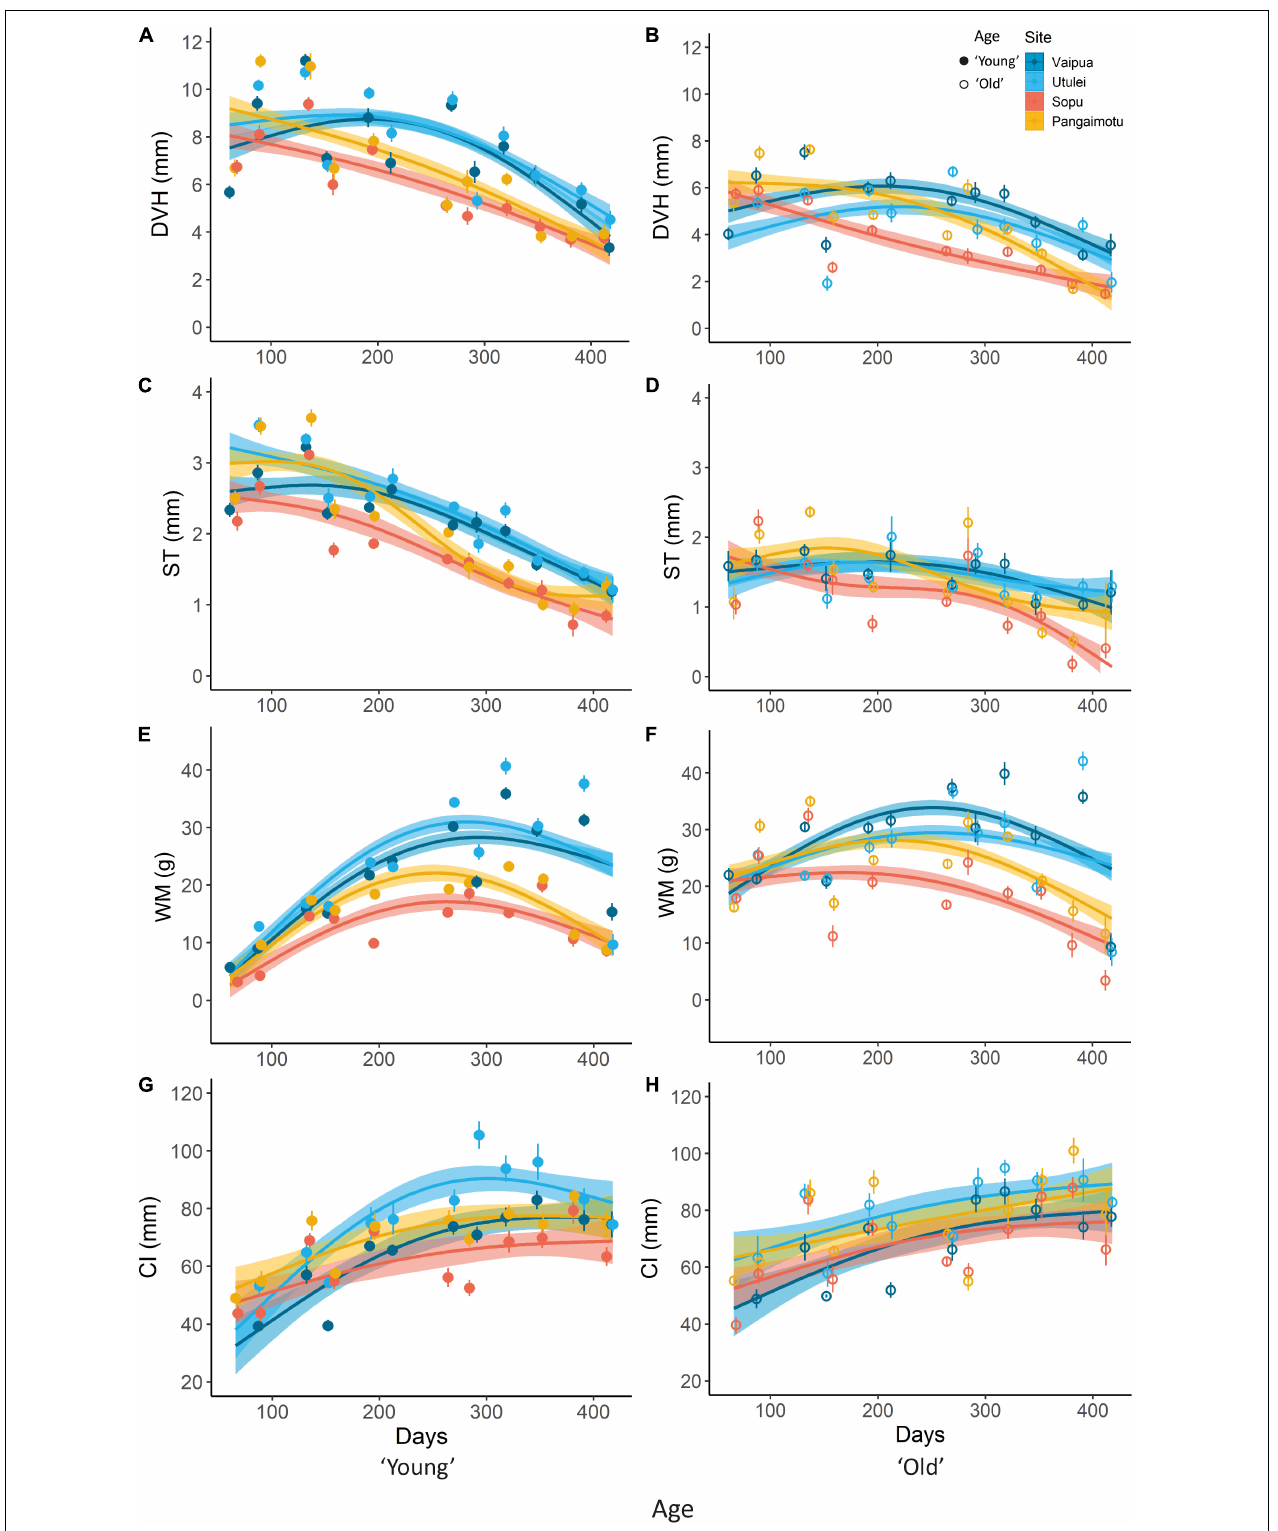
FIGURE 4 | Spatio-temporal trends in mean ( ± SE) monthly growth rate (G M ) and condition index (CI) of Pteria penguin : (A,B) dorso-ventral height (DVH); (C,D) shell thickness (ST); (E,F) wet mass (WM); and (G,H) CI. Splines represent GAM model predictions ± 95% confidence intervals. Where one spline falls within the error envelope of another, there is no significant difference in measurements between those splines for that time